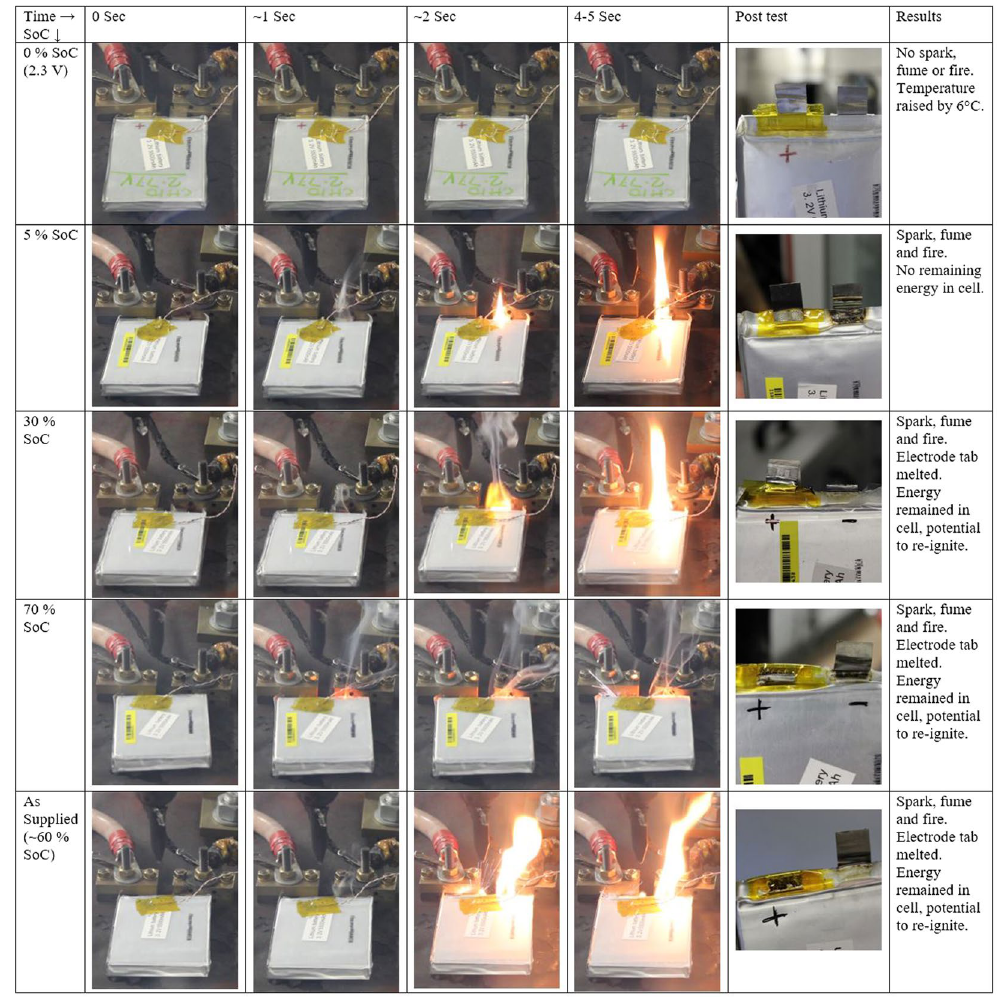
Figure 5. External short-circuit test performed on five cells at 0% SoC (discharged to 2.3 V), 5% SoC, 30% SoC, 70% SoC and as supplied (around 60% SoC) by the manufacturer. From left to right, first picture is just before the short-circuit was applied, just after application of short circuit (~1 sec), 2 second after application of short circuit, maximum fire/spark found (around 4–5 seconds after the short circuit was applied) and in last picture the cell electrode tab after short-circuit test. Results of the test are presented in last